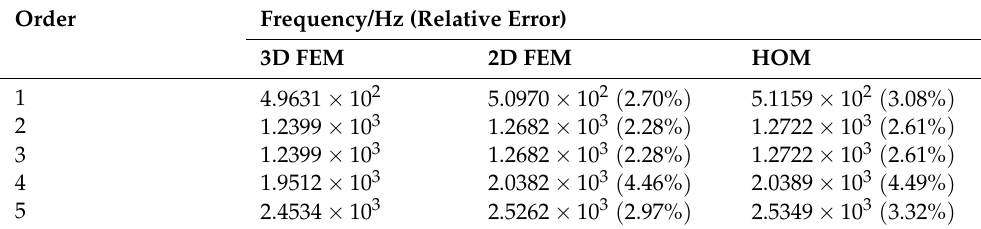
Table 3. First five-order natural frequencies of the SSSS four-layer periodic plate.